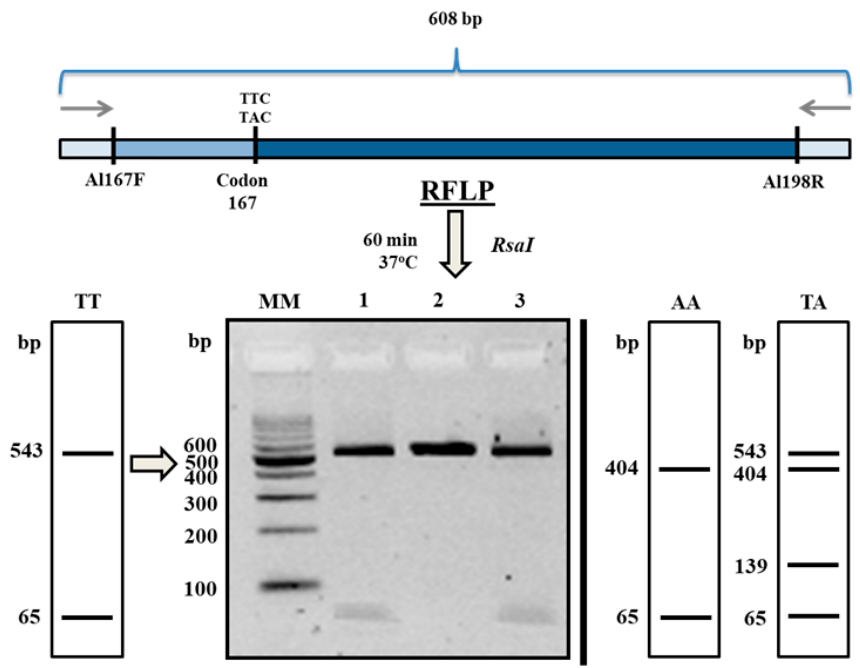
Figure 5. Schematic representation of the PCR-restriction fragment length polymorphism (RFLP) methodology for the screening of β -tubulin polymorphisms of codon 167 in Ascaris suum eggs: TT—unmutated homozygous (TTC / TTC); AA—mutated homozygous (TAC / TAC); TA—heterozygous (TTC / TAC), according to Zuccherato et al. [6] after own modification. Notes: MM—molecular markers; 1,3—exemplary RsaI restriction cleavage products (548 and 65 bp; TT homozygotes); 2—product before restriction analysis (608 bp).